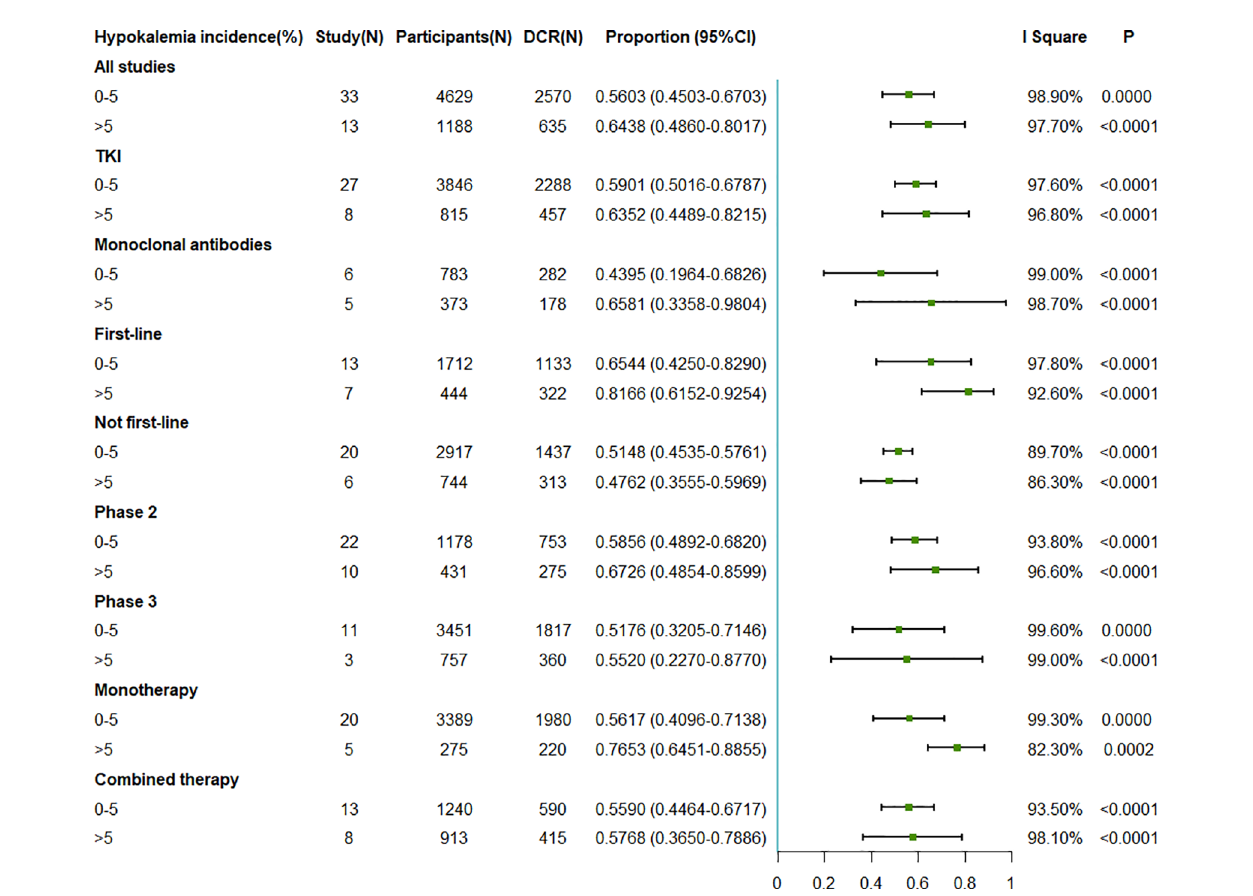
FIGURE 4 | Forest plot for the meta-analysis of the DCR of anti-epidermal growth factor receptor (EGFR) targeted therapy for different incidence rates of grade 3 – 5 hypokalemia. DCR , disease control rate; TKI , tyrosine kinase